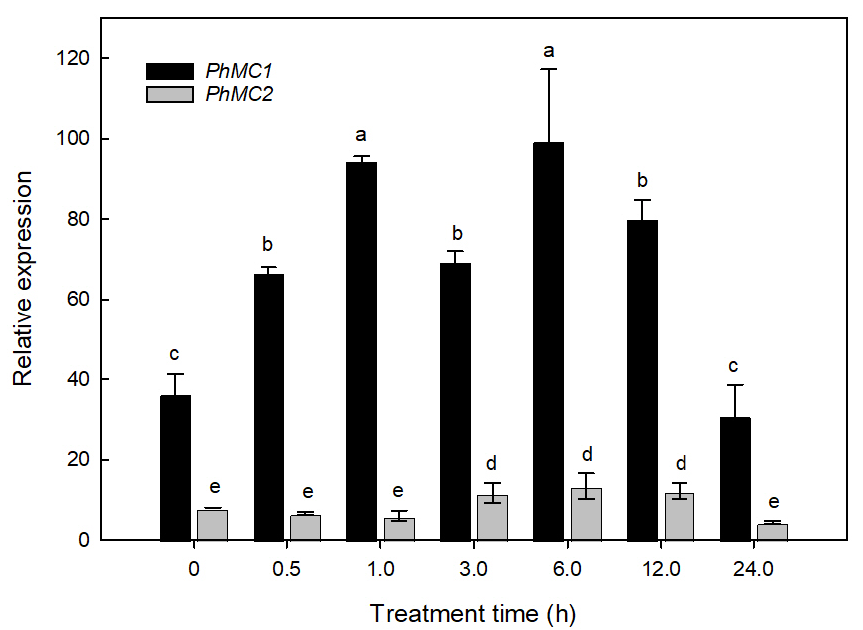
Figure 6. Metacaspase gene expression induced by salinity stress in petunia seedlings. Petunia × hybrida ‘Mitchell Diploid’ seedlings were treated with 100 mM NaCl amended 1 Hoagland’s solution for 0, 0.5, 1, 3, 6, 12, or 24 h. Relative mRNA abundance of PhMC1 and PhMC2 was analyzed in seedling shoot tissue by quantitative PCR. Transcript levels are expressed relative to PhACTIN . Bars represent mean ± SD ( n = 3). Different letters represent statistically significant difference between the means ( p ≤ 0.05).